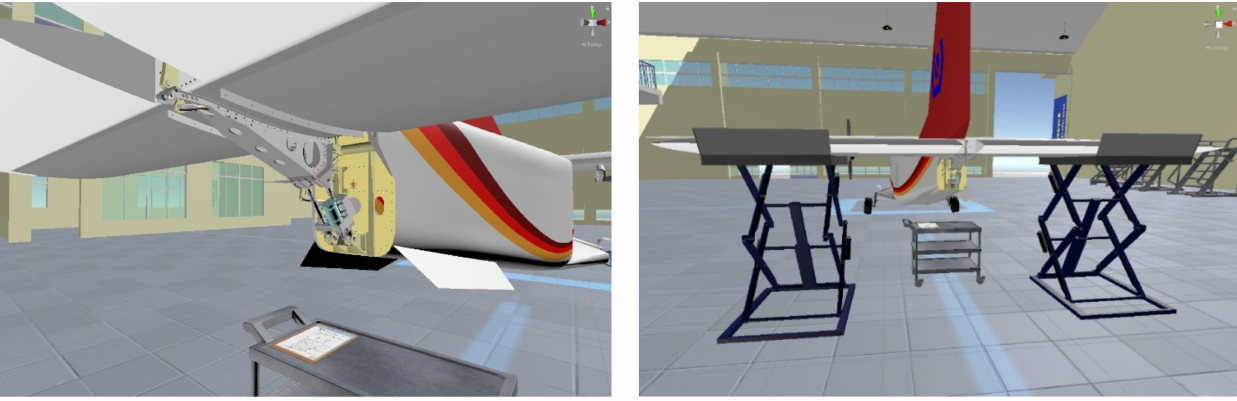
Figure 6. Maintenance scene of horizontal